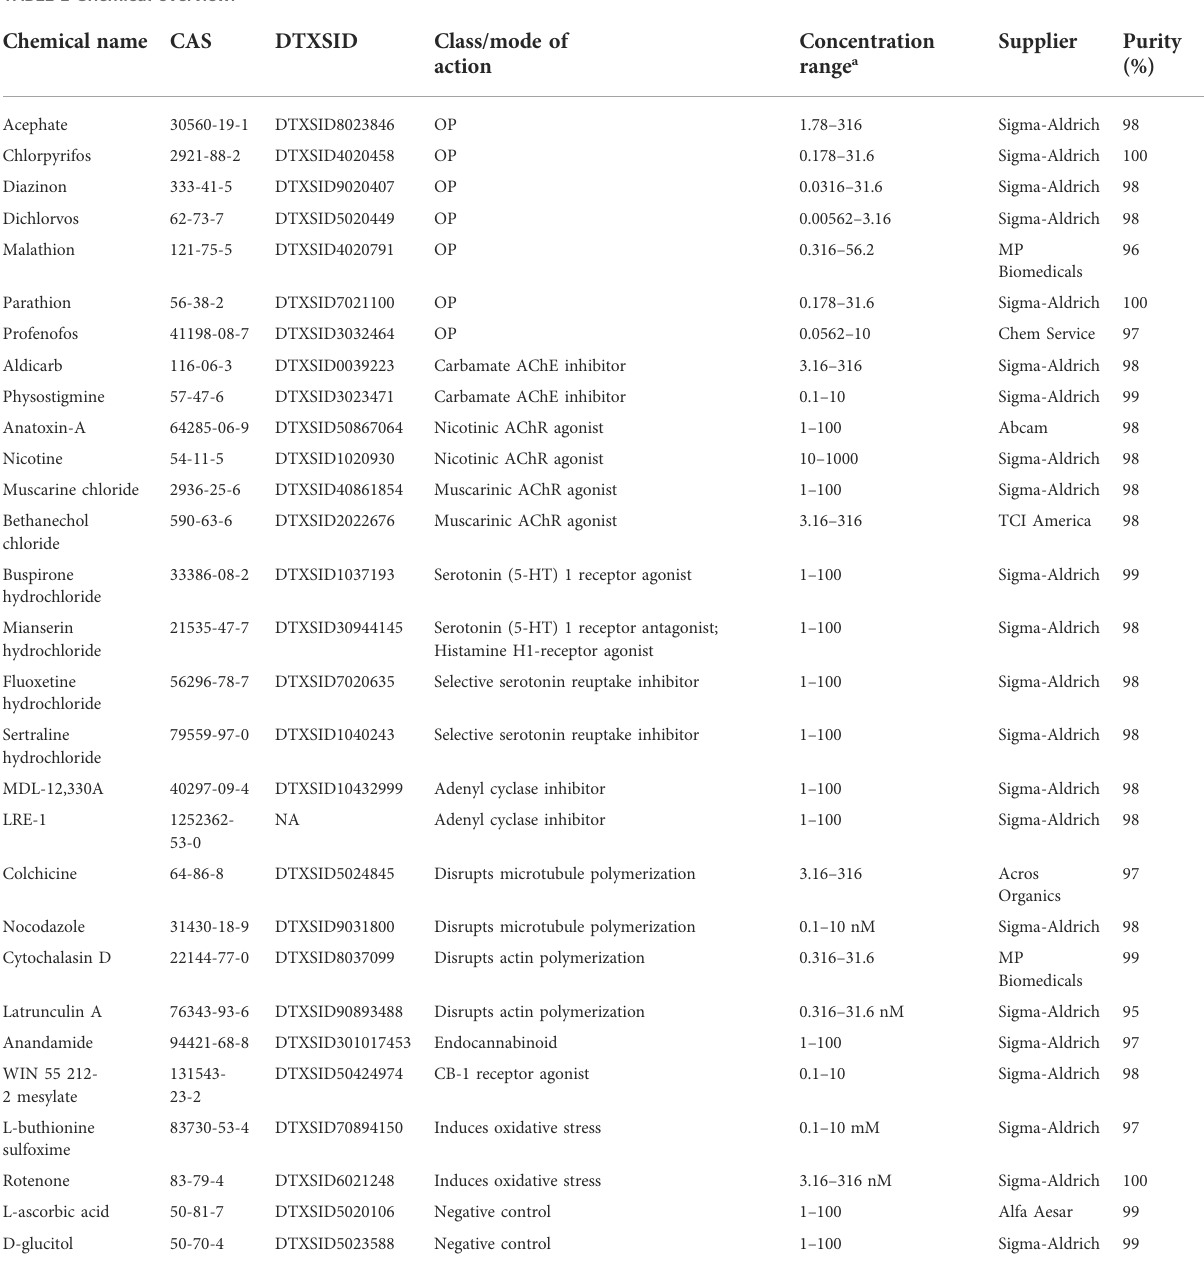
TABLE 1 Chemical